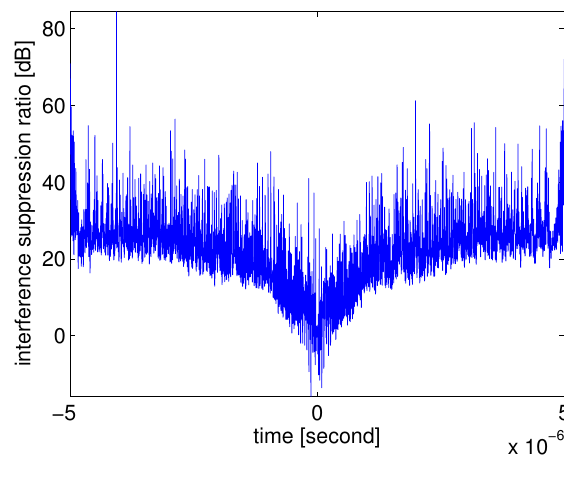
Figure 8. Result of the interference suppression ratio.